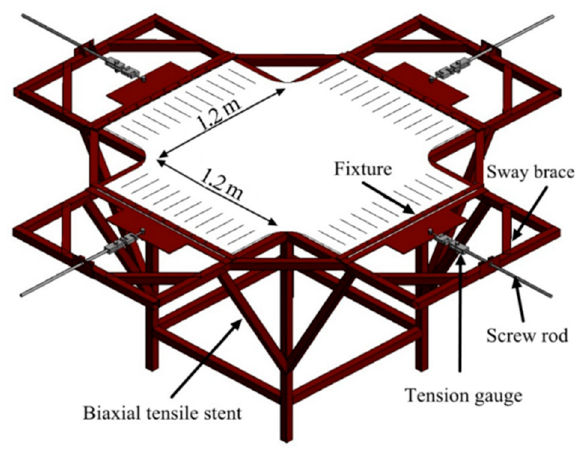
Figure 4. Illustration of pretension device.